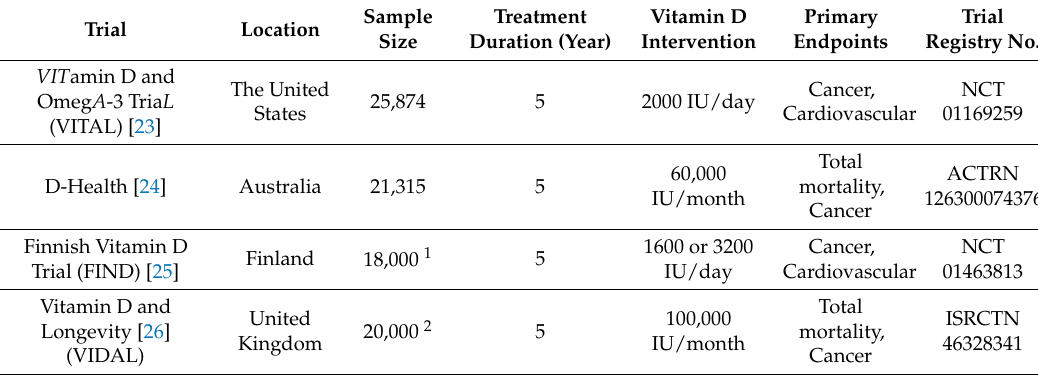
Table 7. Current Randomized-Controlled Trials with >10,000 Participants Investigating Vitamin D Supplementation and Cancer Listed in Clinical Trial